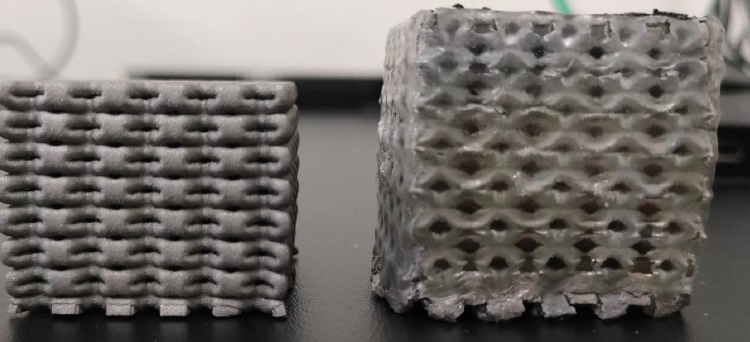
Figure 7. Comparison of 316L metal lattice and epoxy/316L metal lattice composites after compres ‐ sion.